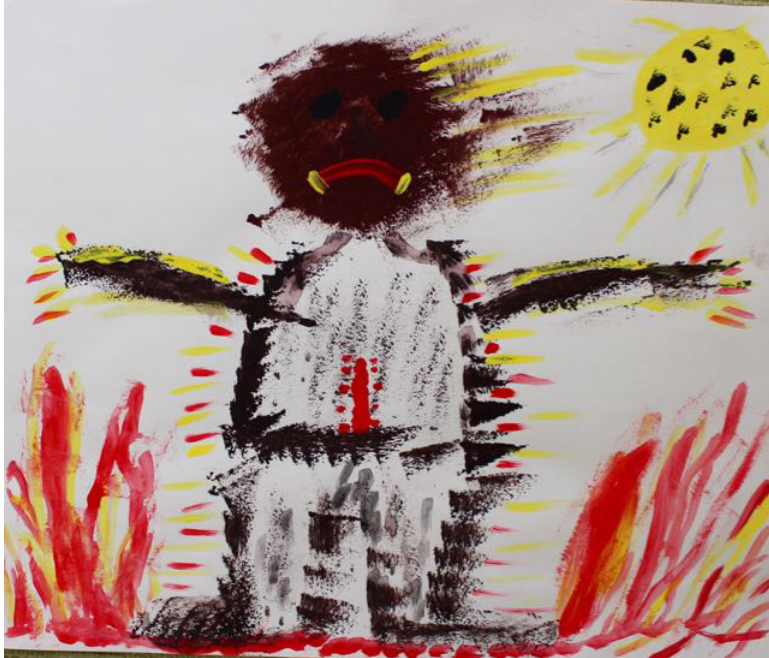
FFigigururee 4.4. CClientlient picturpicturee befbefororee trtreeatmentatment AG: They have cut me in pieces. The soil is burning, and even the sun is blackened. I am standing in the middle of this.